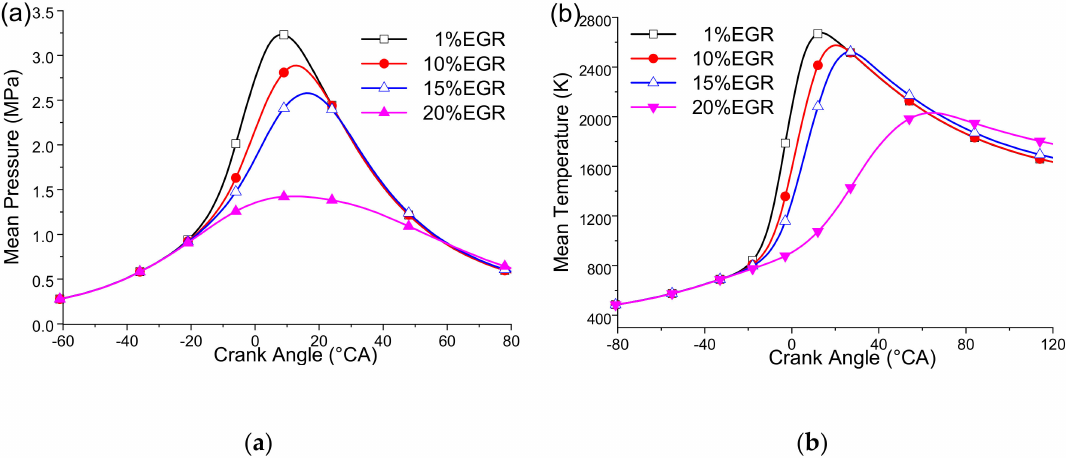
Figure 7. Mean in-cylinder pressure and temperature at di ff erent exhaust gas recirculation (EGR) ratios: ( a ) Mean in-cylinder pressure; ( b ) Mean in-cylinder